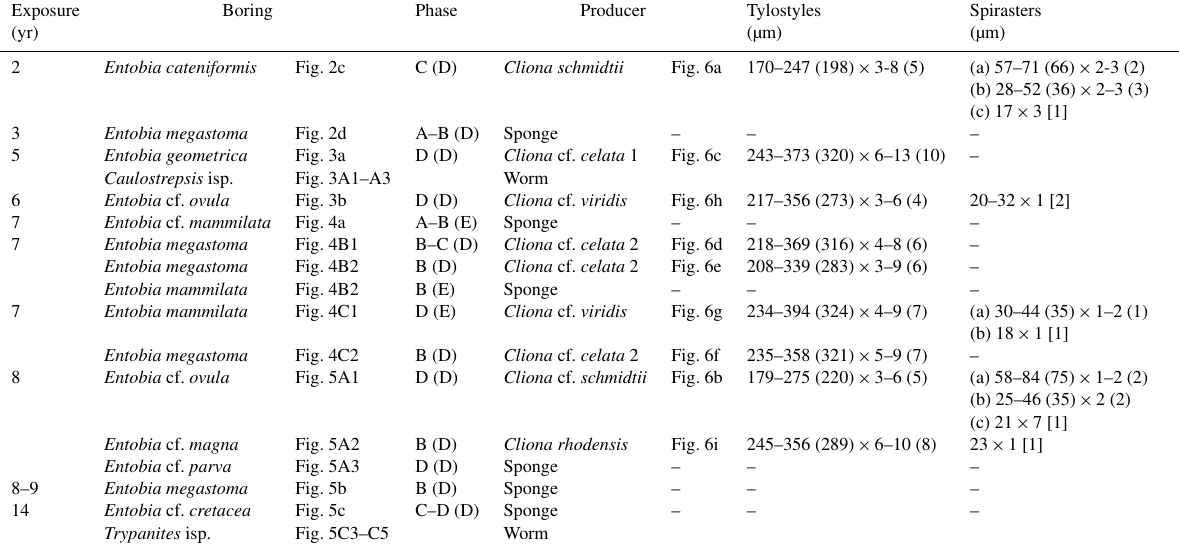
Table 2. Inventory of bioerosion traces. Sponge borings (trace is Entobia ispp.) and boring sponges (trace maker is Cliona spp.) in the scanned experimental blocks were assigned via spicule analysis. Ontogenetic phases of sponge boring traces were determined according to Bromley and D’Alessandro (1984) with most mature stages in brackets. Measurements of sponge spicules are given as ranges, with length before widths, and means in parenthesis. Number of tylostyles is n = 20 and number of spirasters is n = 5 unless otherwise indicated in square